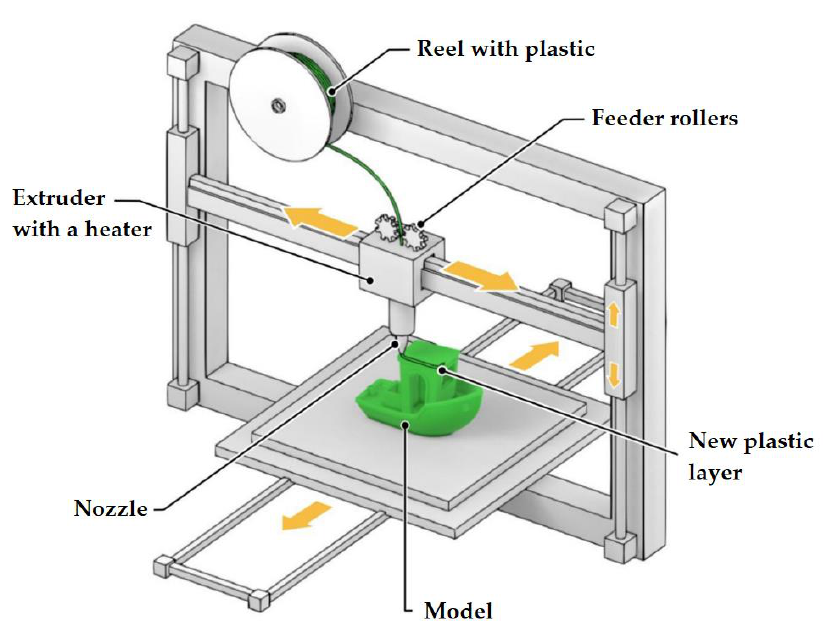
Figure 3. Modeling by layer-by-layer deposition, a schematic diagram.